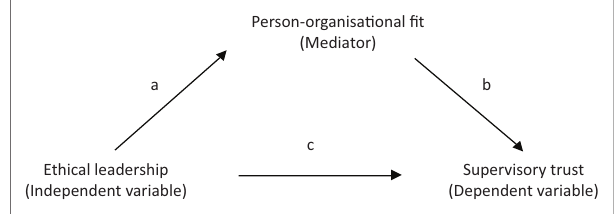
FIGURE 1: A proposed model depicting the role of ethical leadership mediated by P-O fit in earning supervisory